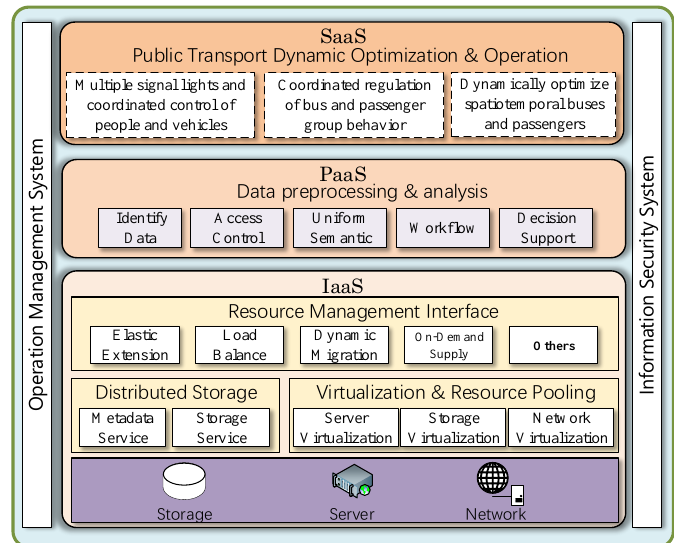
Figure 4. Hierarchy of CPSS-UPTDN computational